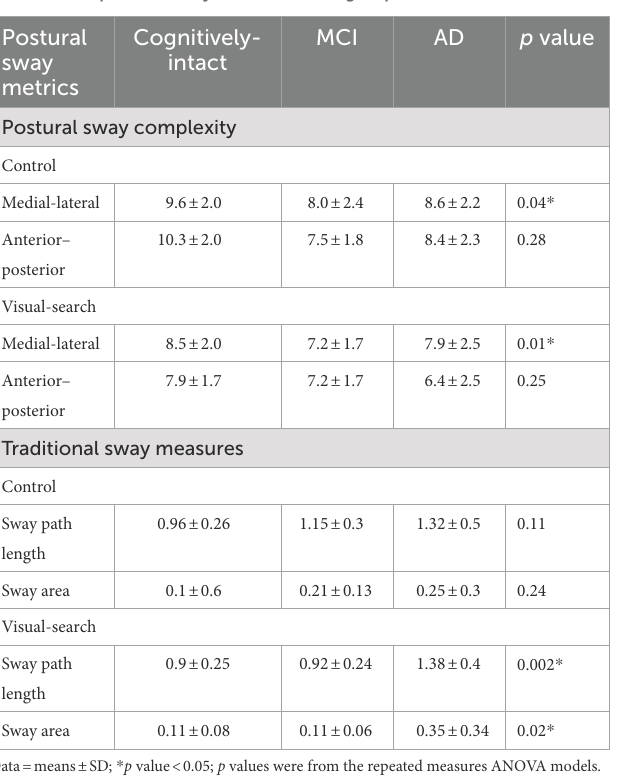
TABLE 2 The postural sway metrics in each group.